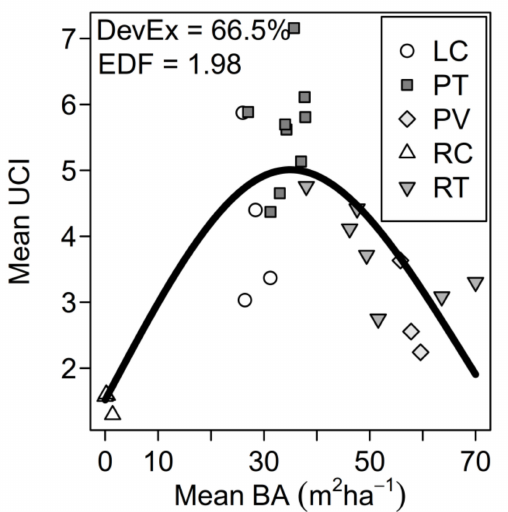
Figure 8. Relationship between the understory complexity index (UCI) as a measure of under- story layer complexity and basal area (means per plot). DevEx = amount of deviance explained, EDF = effective degrees of freedom, LC = La Campana, PT = Parque Tantauco, PV = Parque Nacional Villarica, RC = Reserva Nacional las Chinchillas, RT = Reserva San Pablo de Tregua. Bold line: visualization of the fitted generalized additive modeling (GAM) model.